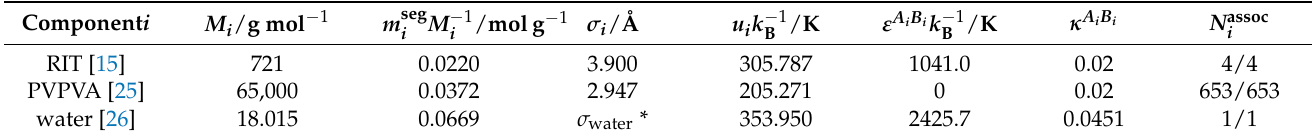
Table 4. PC-SAFT pure-component parameters of RIT, PVPVA, and water. Component i